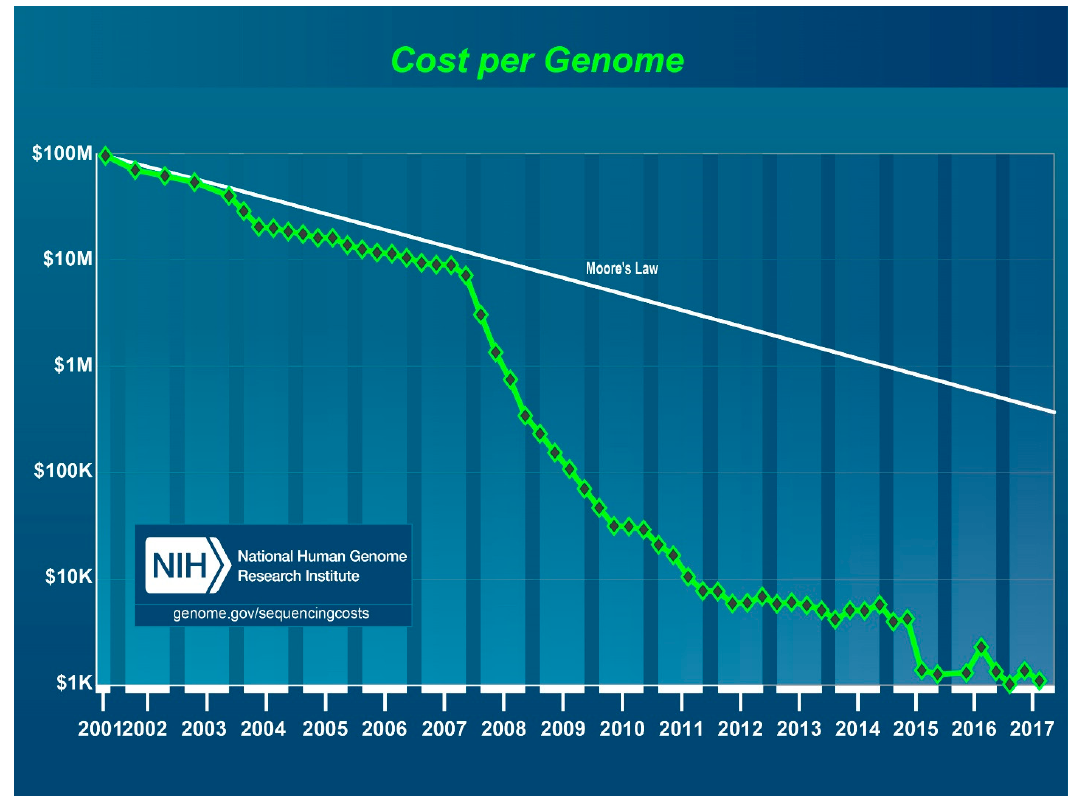
Figure 1. Cost per human genome sequencing in US Dollars from 2001 to 2017 as estimated by the National Human Genome Research Institute, US National Institutes of Health, Bethesda, MD, USA. During this time period, first generation Sanger sequencing methods were used from 2001 through 2007 and NGS platforms from 2008 to 2017.